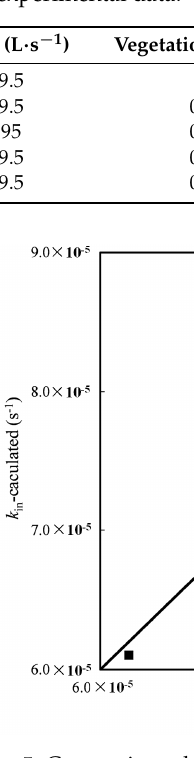
Figure 5. Comparisons between k in -calculated and k in -calibrated.